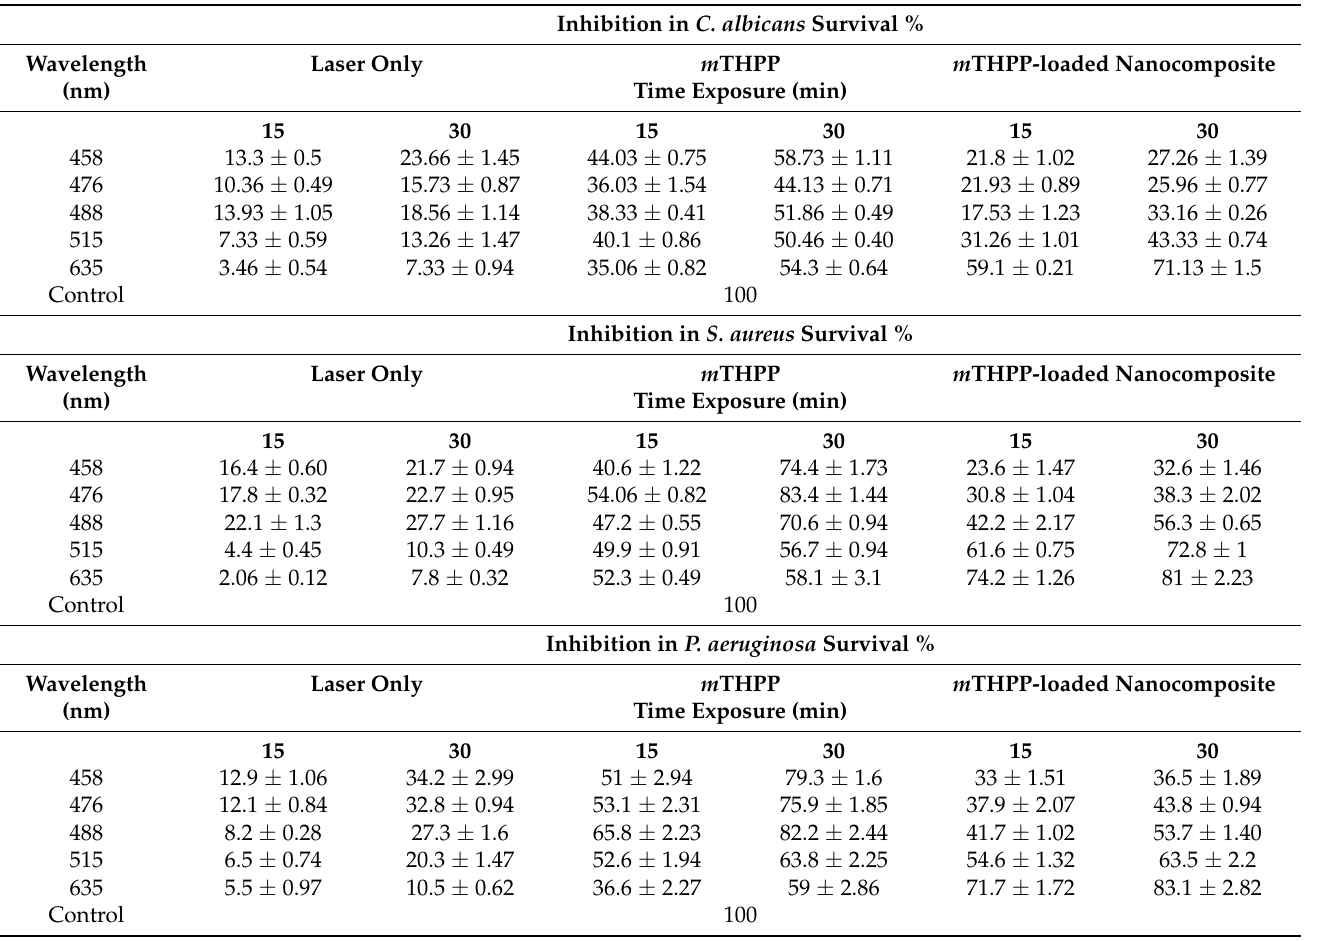
Table 3. Antimicrobial photodynamic therapy of m THPP and m THPP-loaded nanocomposite at different